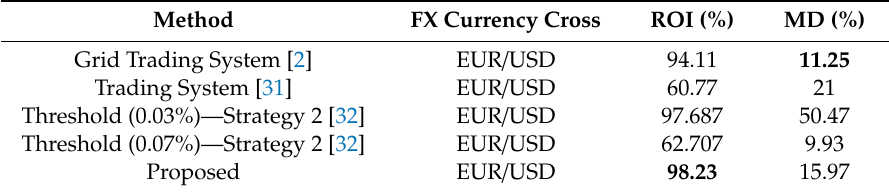
Table 2. Trading performance analysis of the proposed